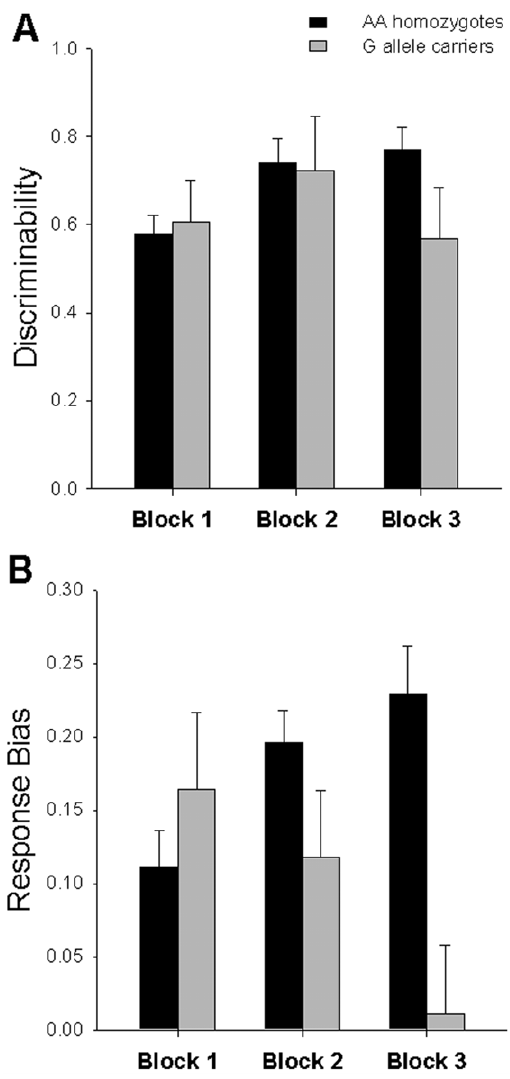
Figure 1. Mean discriminability and response bias across blocks for AA homozygotes and G allele carriers. AA homozy- gotes (black bars) did not differ from G allele carriers (gray bars) in measures of discriminability (A). There was, however, a genotype group 6 block interaction for response bias (B), in which AA homozy- gotes had increased response bias over time, while G allele carriers had decreased response bias over time. Error bars represent standard errors.